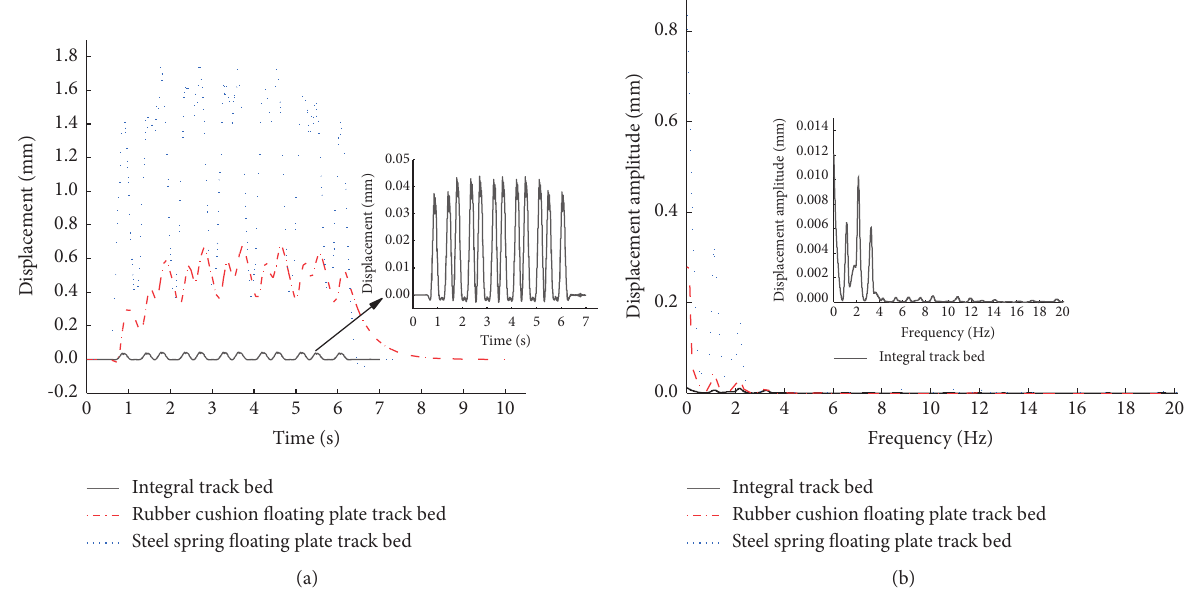
Figure 13: The vertical displacement (a) time-history and (b) amplitude-frequency curve of the right monitoring point under different trackbed